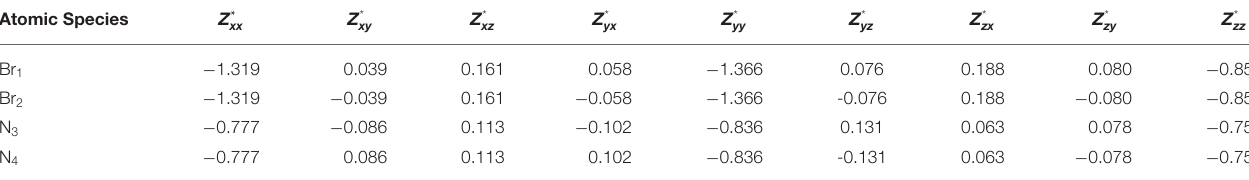
−→ E = = 0.01 ˆ x + 0.01 ˆ y